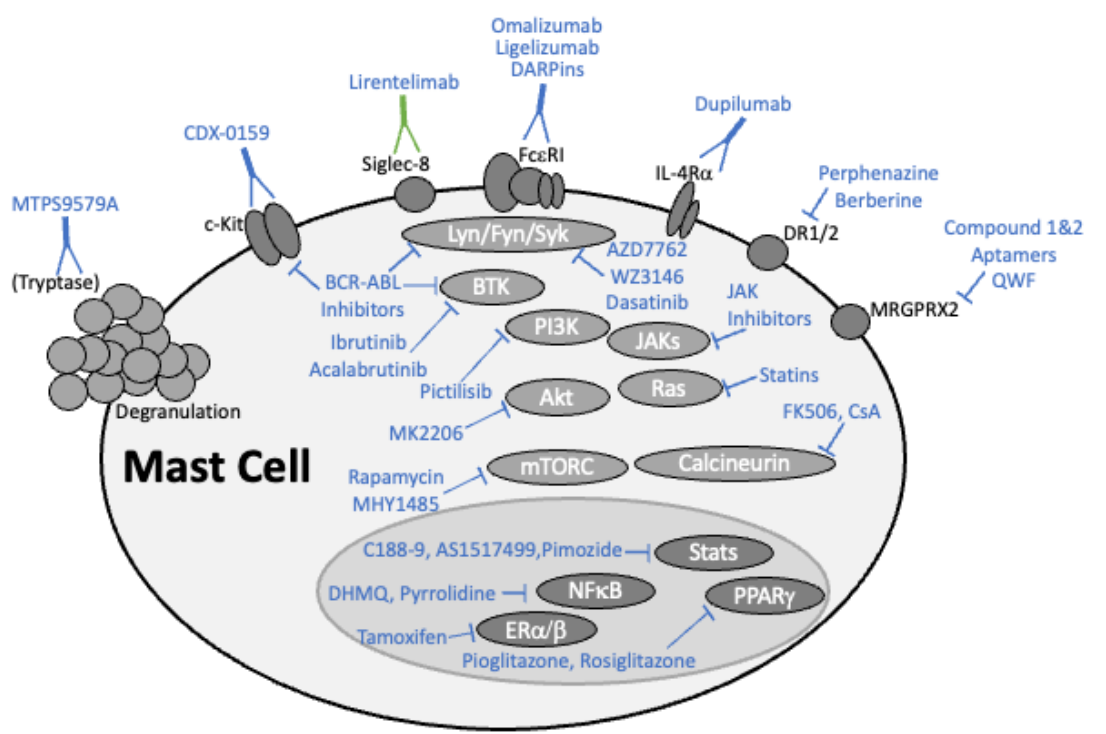
Figure 2. Visual representation of drugs with known or potential ability to disrupt mast cell function. Monoclonal antibody-based drugs are shown as Y-shaped symbols. As described in the text, many of the drugs are shown with their known or proposed off-target effects (e.g., BCR-Abl inhibitors with known effects on many kinases). All drugs shown have antagonistic effects except lirentelimab, which is depicted in green to indicate its agonist actions on the inhibitory receptor Siglec-8.